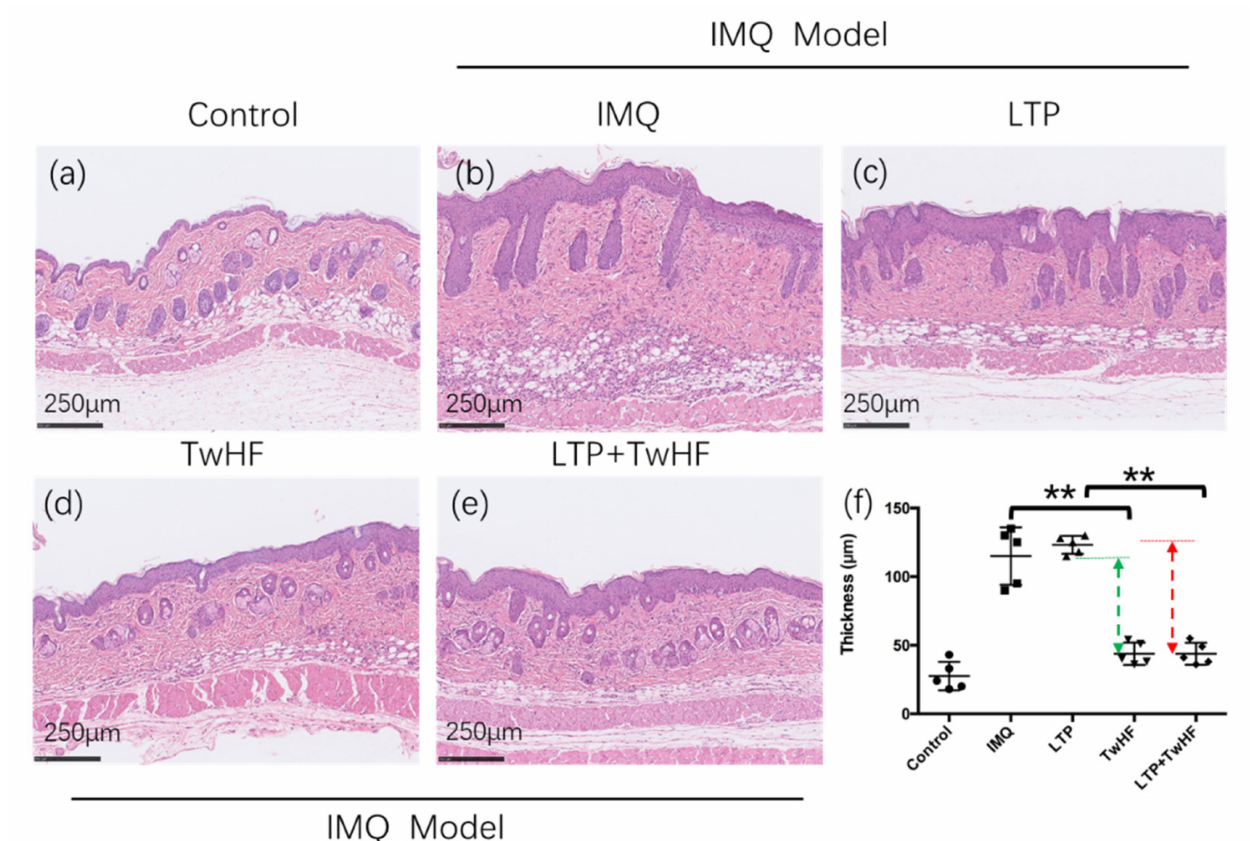
Figure 8. H&E staining of the dorsal skin with the original magnification of 200 × . ( a ) Control case, ( b ) IMQ case, ( c ) LTP treatment case, ( d ) TwHF treatment case, ( e ) LTP+TwHF treatment case. ( f ) The thickness of epidermis. Data are expressed as mean ± SD ( n = 5 mice/group, ** p < 0.01). One representative of three separate experiments is shown while all results were similar among these three experiments. The comparison between the red dash line and the green dash line suggests that the LTP + TwHF psoriasiform dermatitis is more efficient at suppressing epidermal thickening and inhibiting systemic